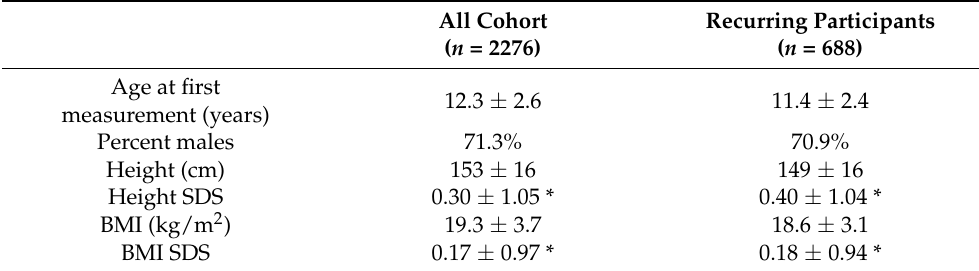
All Cohort Recurring Participants ( n = 2276) ( n = 688) 12.3 ± 2.6 11.4 ± 2.4